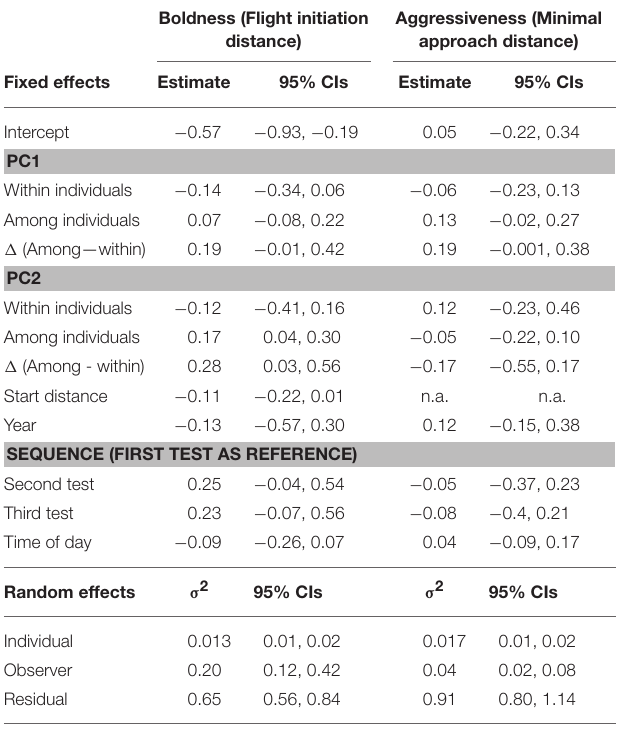
TABLE 1 | Sources of variation in boldness and aggressiveness. Boldness (Flight initiation